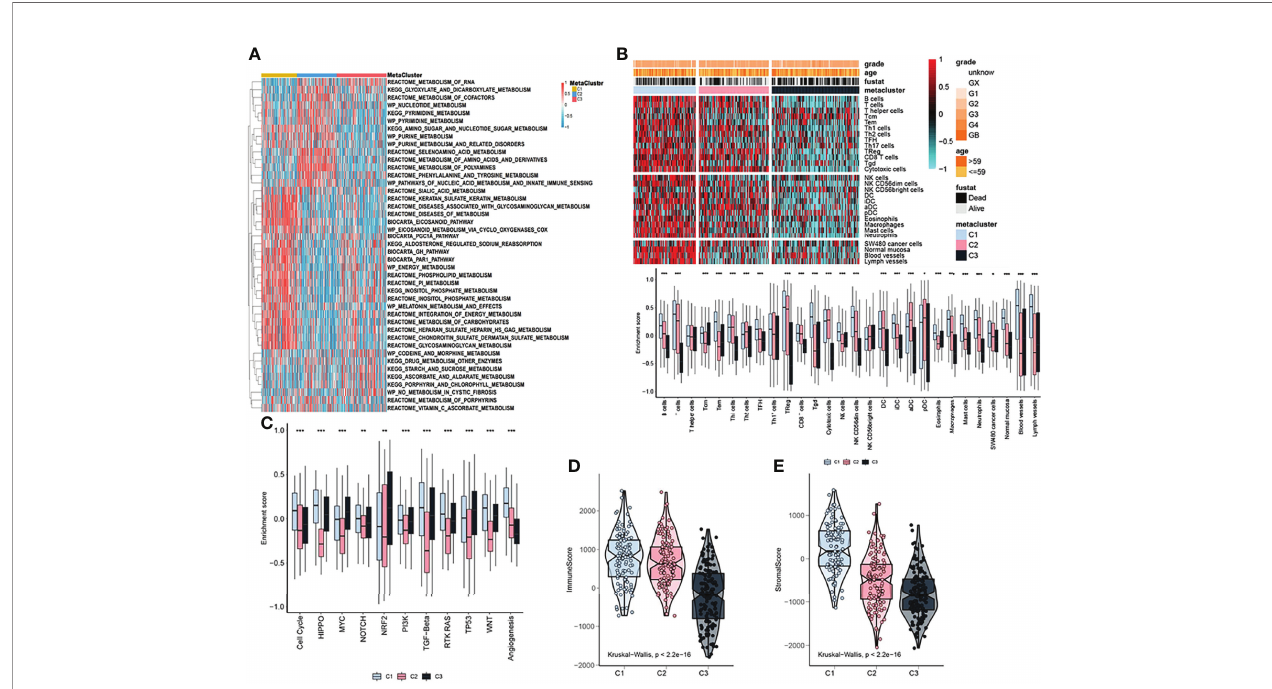
FIGURE 2 | Metabolic and immune characteristics of OV subtypes. (A) Heatmap showing that the ssGSEA algorithm quantitatively identi fi ed differential metabolic pathways among the identi fi ed subtypes. (B) Heatmap (upper pane) and boxplot (lower pane) indicating the differences in immune characteristics of the identi fi ed subtypes. (C) Boxplot showing the differences in pathway enrichment scores among the three identi fi ed subtypes. (D) Immune score differences among the identi fi ed subtypes. (E) Stromal score differences among the identi fi ed subtypes. The statistical difference was compared through the Kruskal – Wallis test, and the P values are labeled above each boxplot with asterisks ( *P < 0.05, **P < 0.01, ***P <